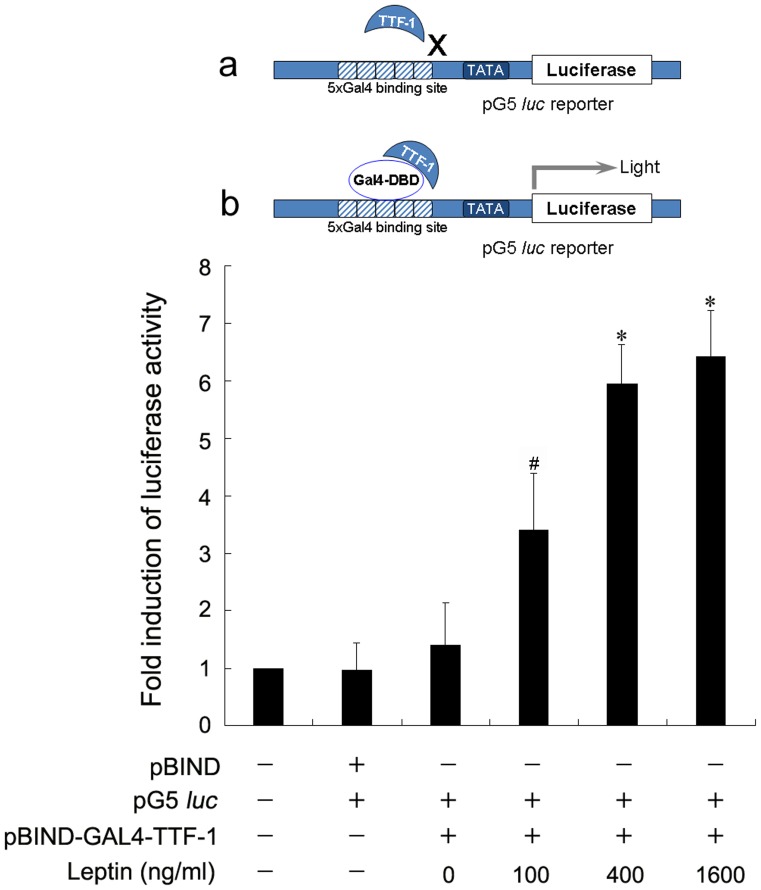
Effect of leptin on the transcriptional activity of TTF-1.A plasmid mixture of pG5, TK-renilla reporter constructs, and pBIND-GAL4-TTF-1 were transfected into A549 cells. After transfection for 6 h, the A549 cells were further cultured with the indicated dosage of leptin for 24 h. The cells were lysed and luciferase activity was measured and normalized by renilla luciferase activity. Results are shown as fold induction in relation to the activity in controls. *P<0.01 vs the control cells (n = 3).